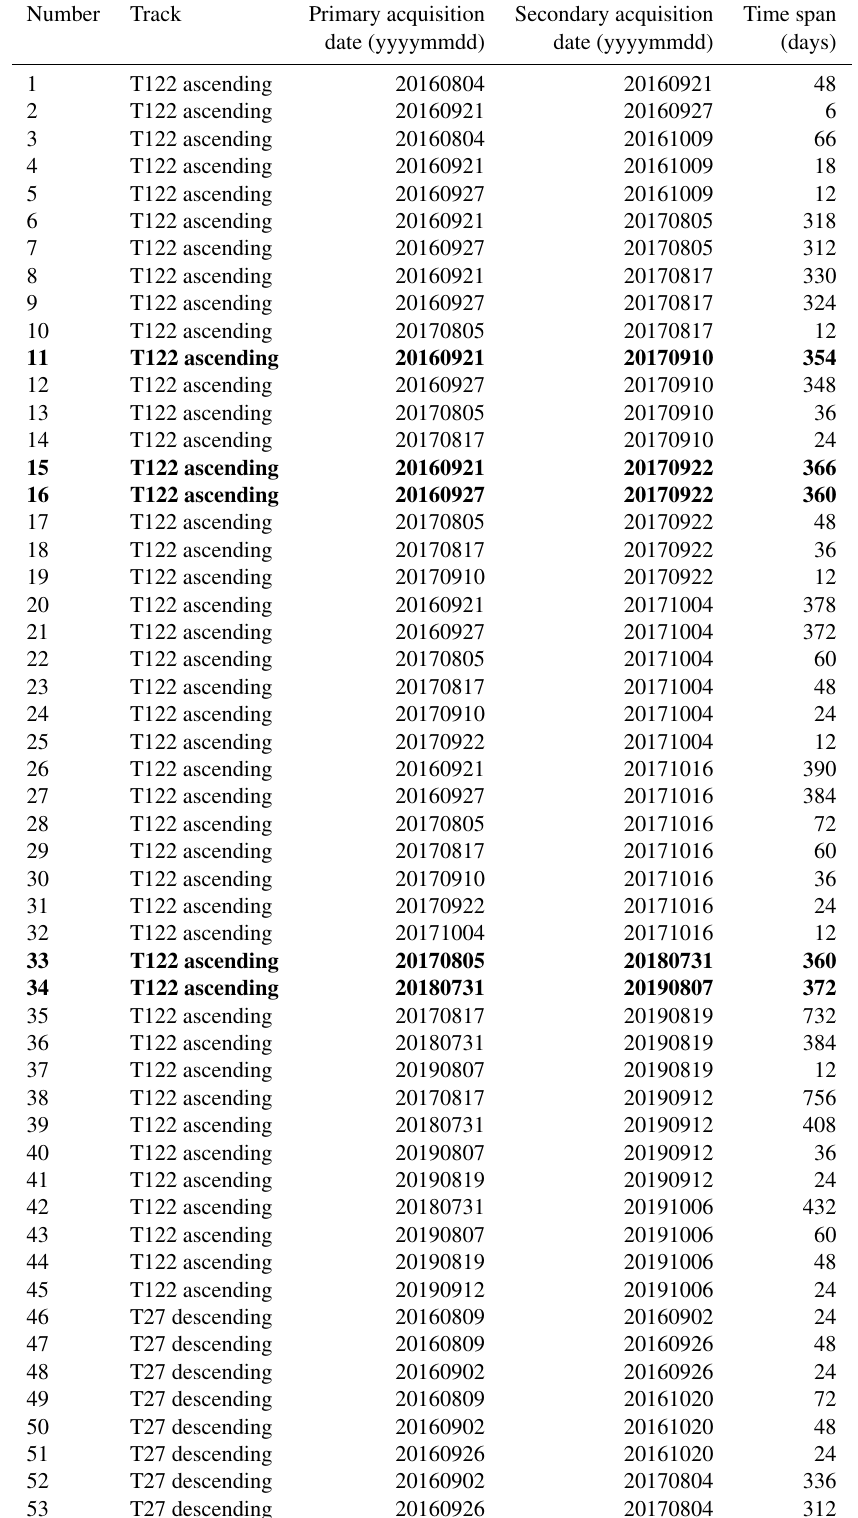
Table A1. Track, date, and time span of all interferograms generated. Pairs that were averaged to create the ascending and descending 1-year stacks used to estimate LOS velocities of rock glaciers are